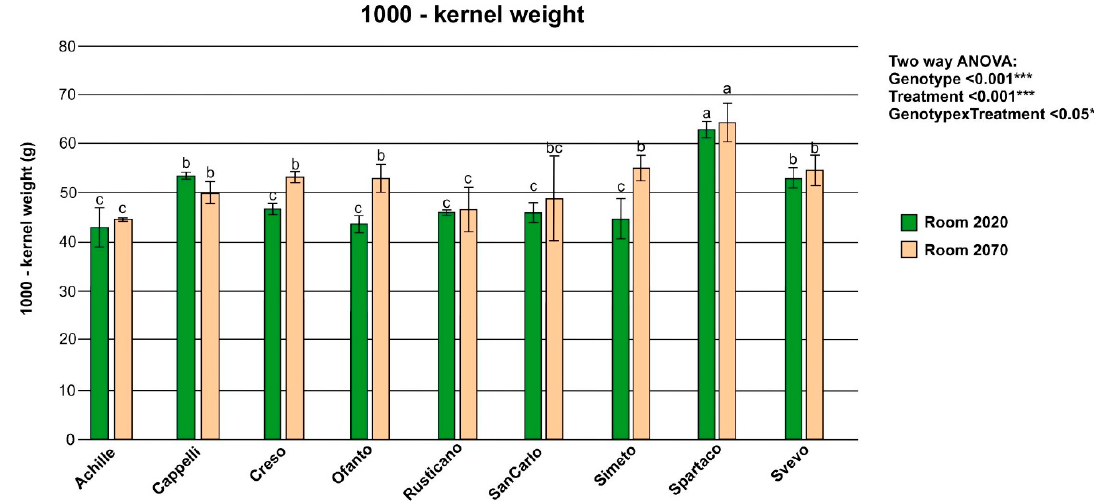
Figure 7. 1000-kernel weight per cultivar grown in “room 2020” and in “room 2070”. Top right: Two-way ANOVA results (*** p < 0.001; * p < 0.05). Letters (a), (b), and (c) refer to significantly different means across the genotypes and the treatment (Tukey-HSD post hoc test, p < 0.05).